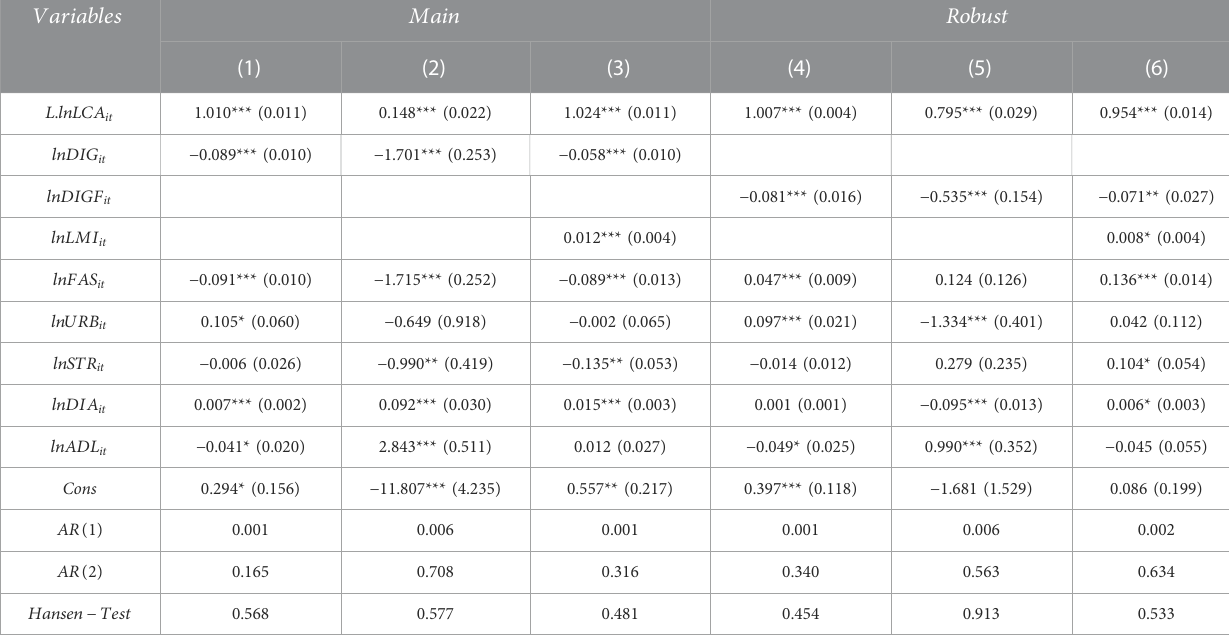
TABLE 8 The results of the mediating effect of agricultural labor